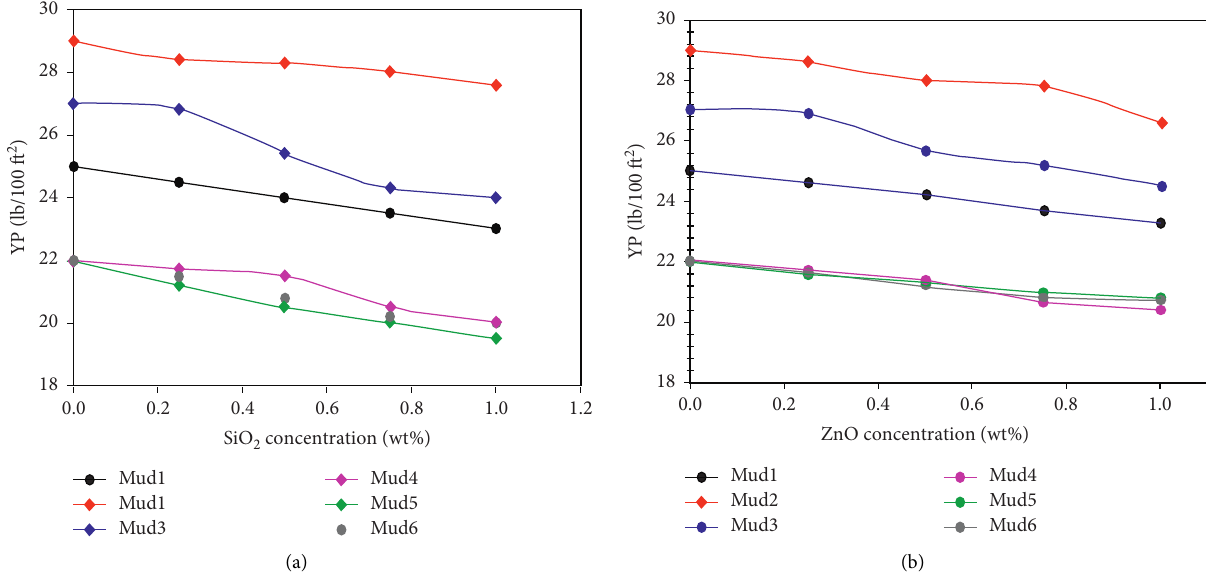
Figure 4: Yield point values of 6 different mud systems (a) with and without silica dioxide NPs and (b) with and without zinc oxide NPs at different concentration